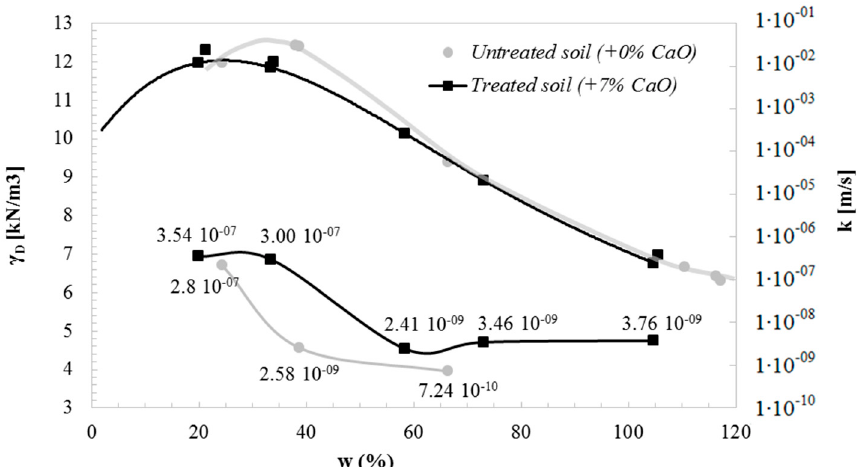
Figure 7. Moisture–dry unit weight relationship, Proctor plane (left y-axis), and long-term permeability values (right y-axis) for untreated compacted soil and for soil treated with 7% CaO.